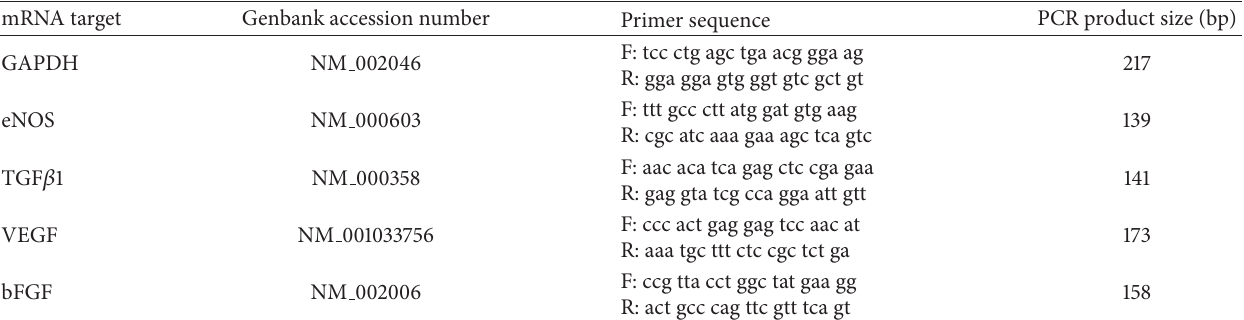
Table 1: List of primers for qPCR